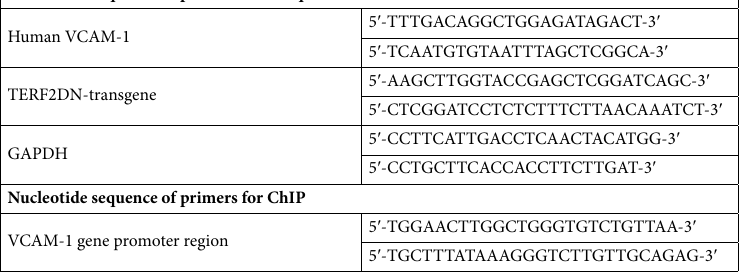
Table 1. The nucleotide sequence of